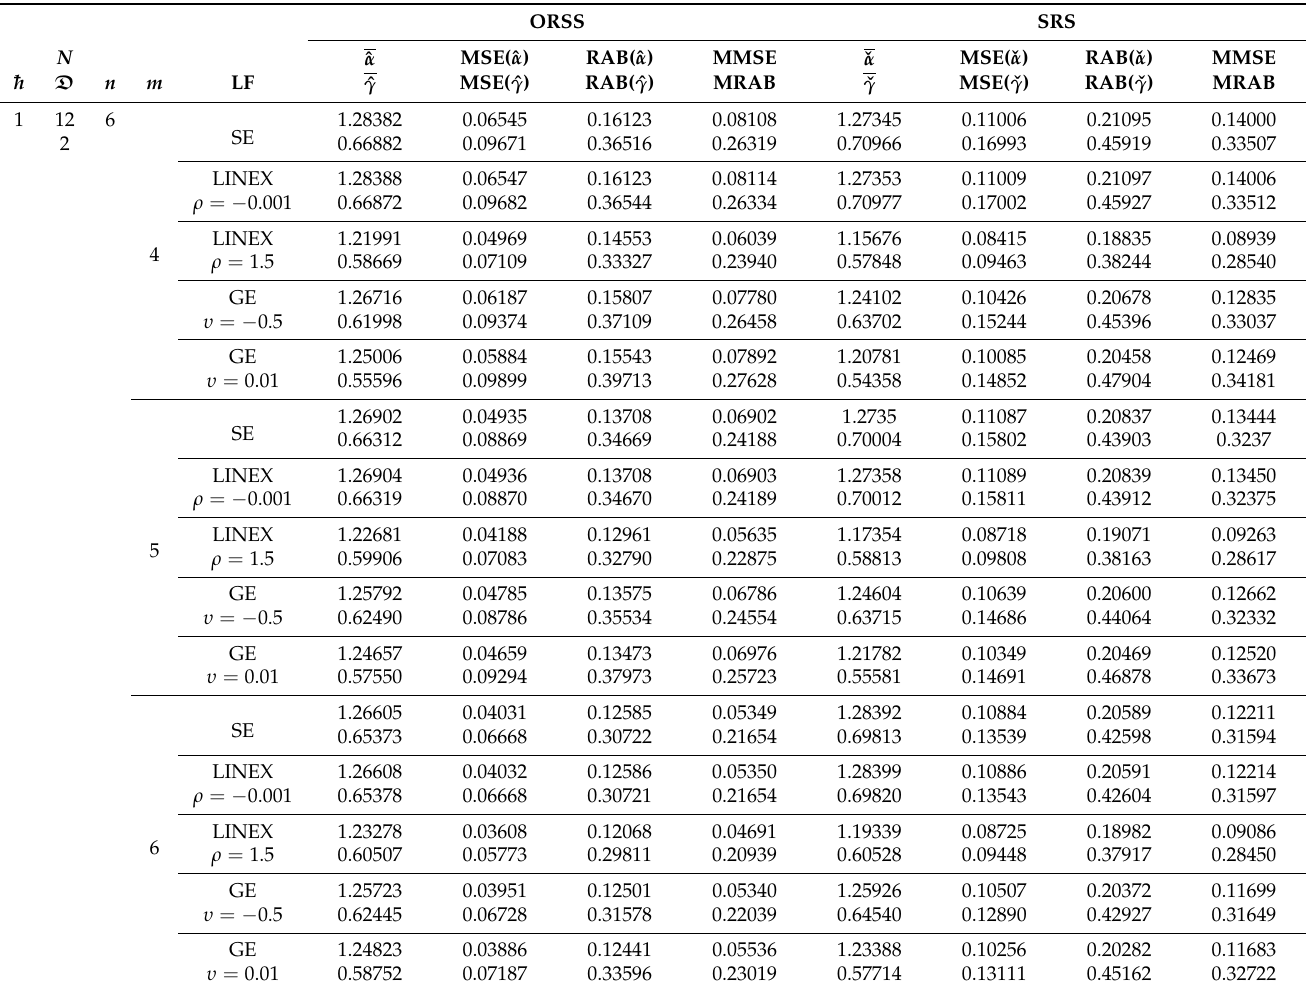
Table A3. BEs of α and γ with their MSEs, RABs, MMSE and MRAB based on 1000 SRSs and ORSSs of size N =